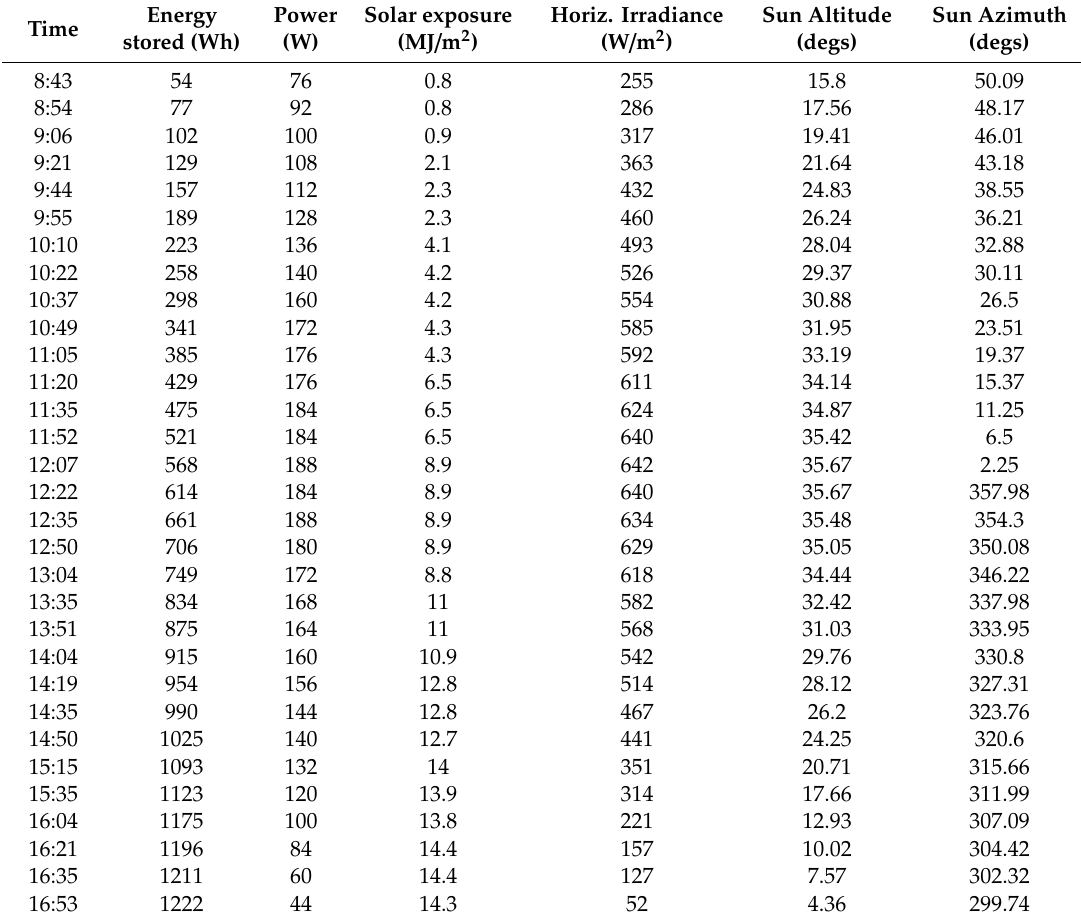
Table 1. Example of the daily dataset collected from the installation data interface and online data sources on June 4 th ,